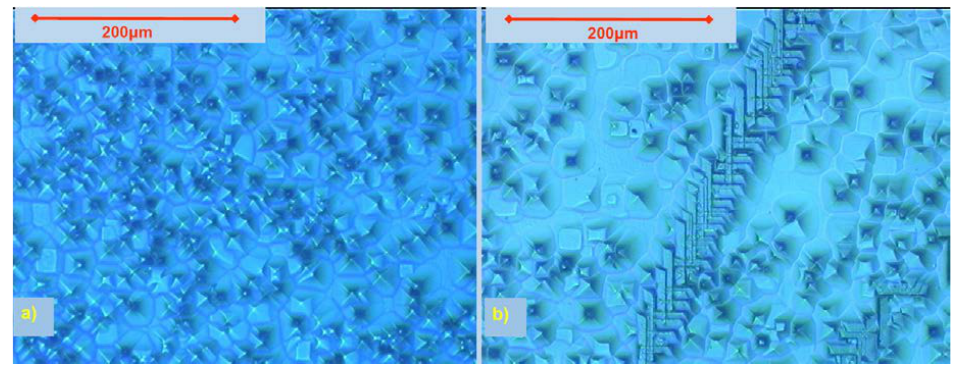
Figure 7. SrTiO 3 crystal, example of the distribution of the etch pits in the plane of (100) for the central region of the crystal ( a ). Photography ( b ) shows an agglomeration of dislocations along both orthogonal directions <100>.